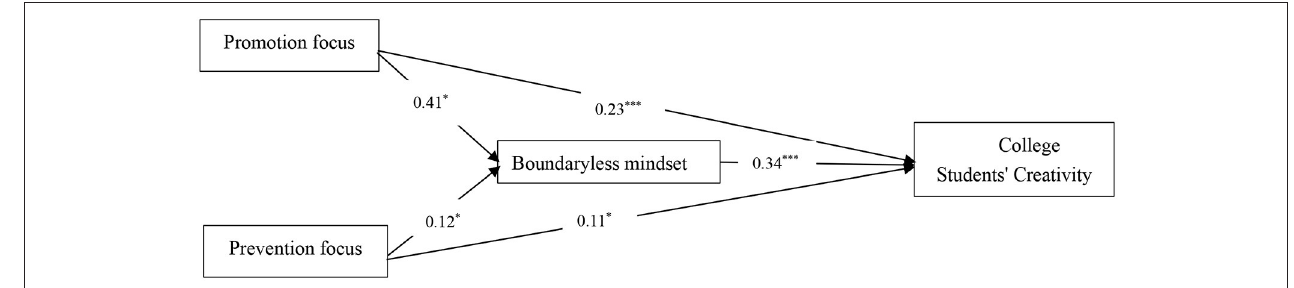
FIGURE 2 | The partial mediation model where promotion focus and prevention focus through the boundaryless mindset affect